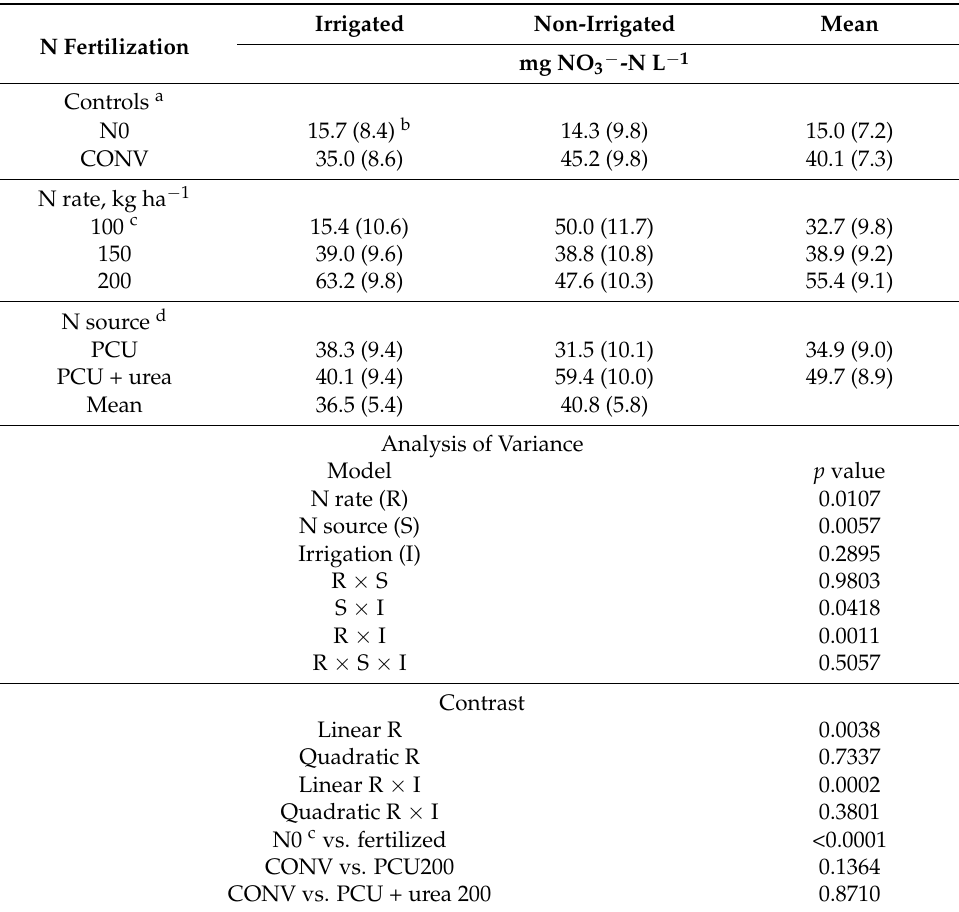
Table 2. Flow-weighted mean NO 3 − -N concentrations as affected by nitrogen fertilization and irrigation. Irrigated Non-Irrigated N Fertilization Controls